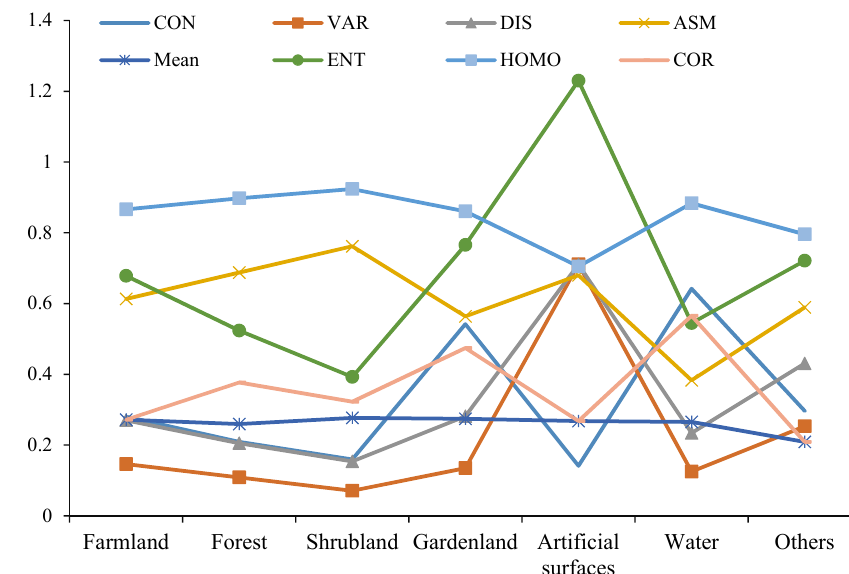
Figure 8. Texture values for land cover types based on OLI data. (Remark: CON: contrast; VAR: variance; DIS: dissimilarity; ASM: angular second moment; Mean: mean; ENT: entropy; HOMO: homogeneity; COR: correlation).